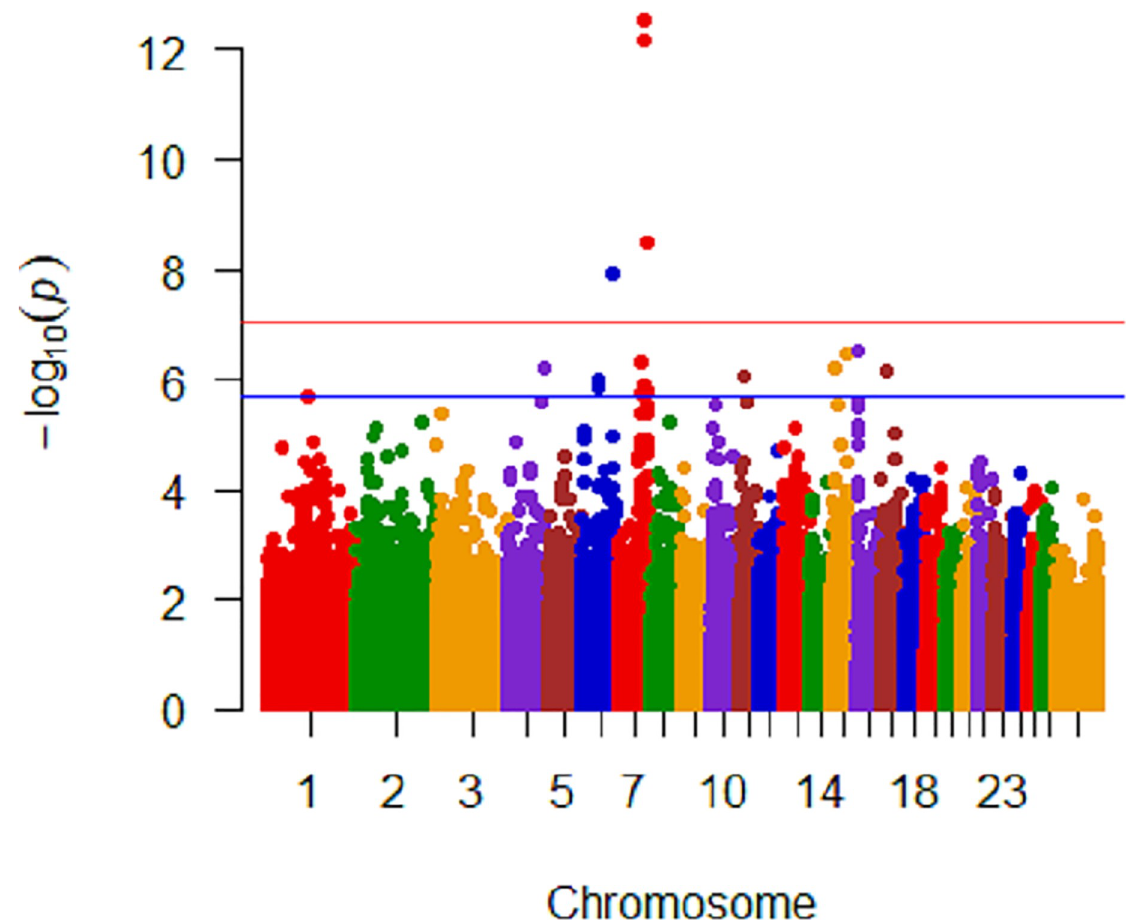
Fig 2. Manhattan plot of all breed analysis with untransformed M . ovipneumoniae mean DNA copy number showing significant SNPs on chromosomes 6 and 7. Genome significant line is red and genome suggestive line is